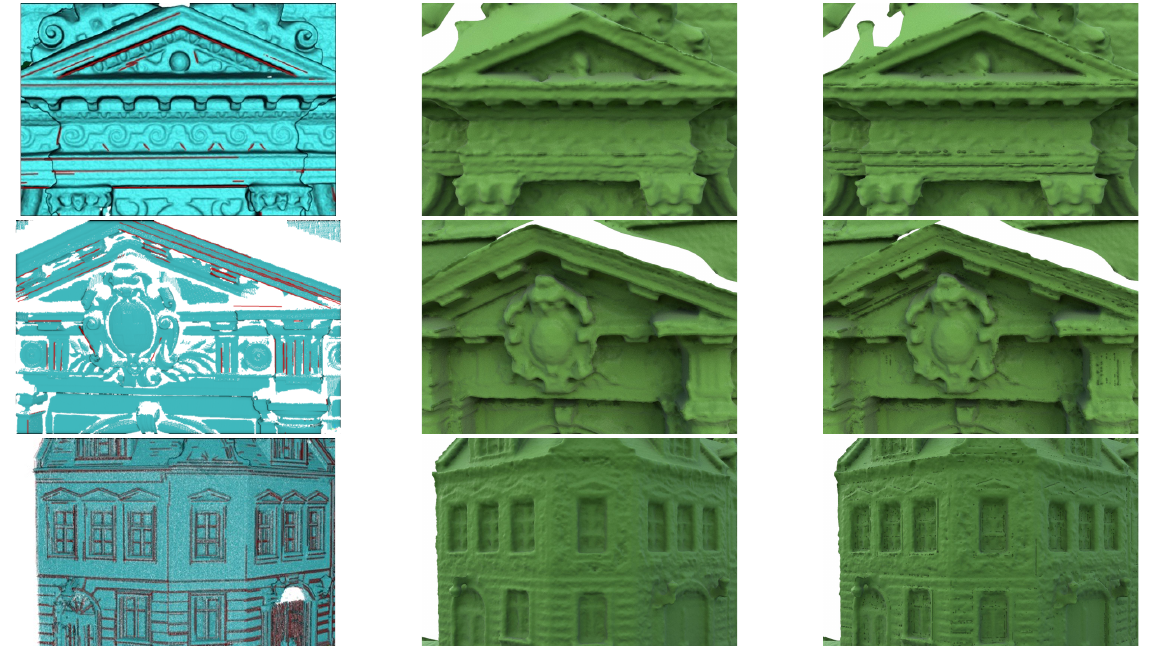
Figure 5. GT mesh and clouds with overlaid 3D edges in red (left) standard MVS mesh (centre) mesh with edge details (right). Fountain-P11 (upper row), ETH3D-Facade (middle row), DTU-006 (lower row).